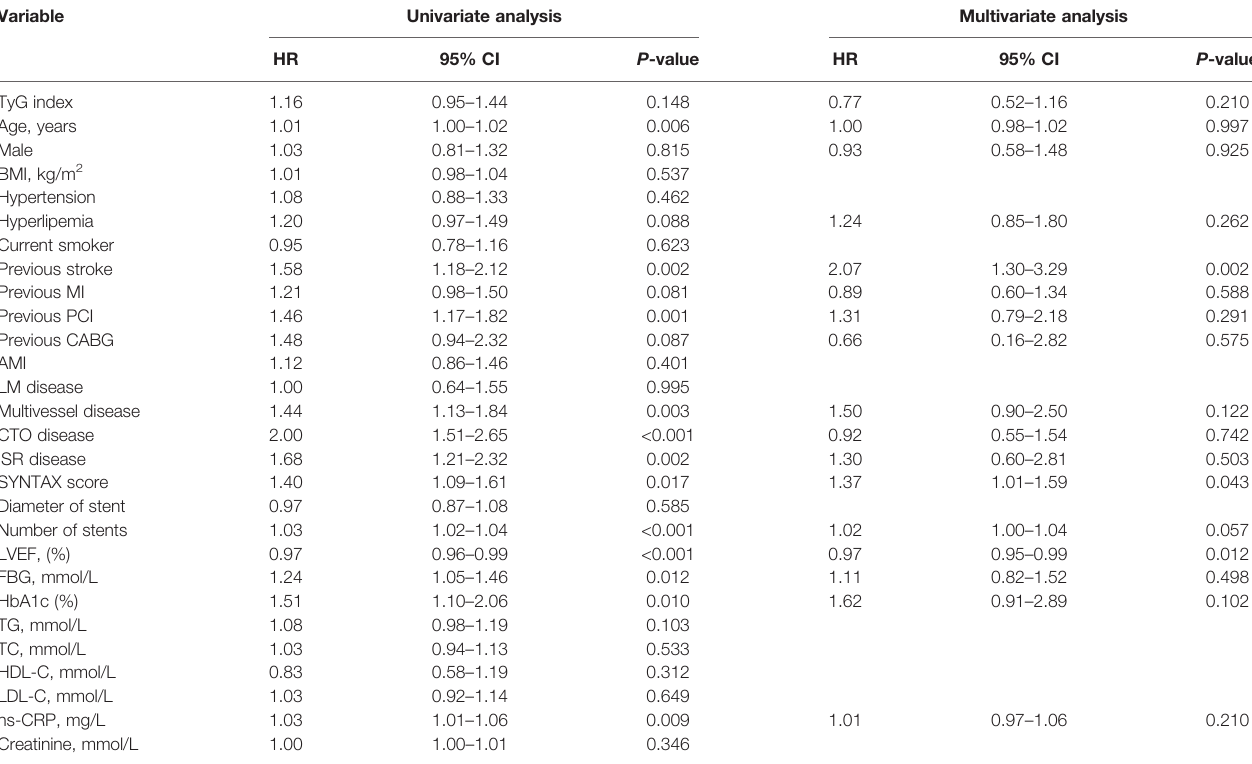
TABLE 3 | Univariate and multivariate Cox regression analyses for predicting the occurrence of MACCE. Variable Univariate